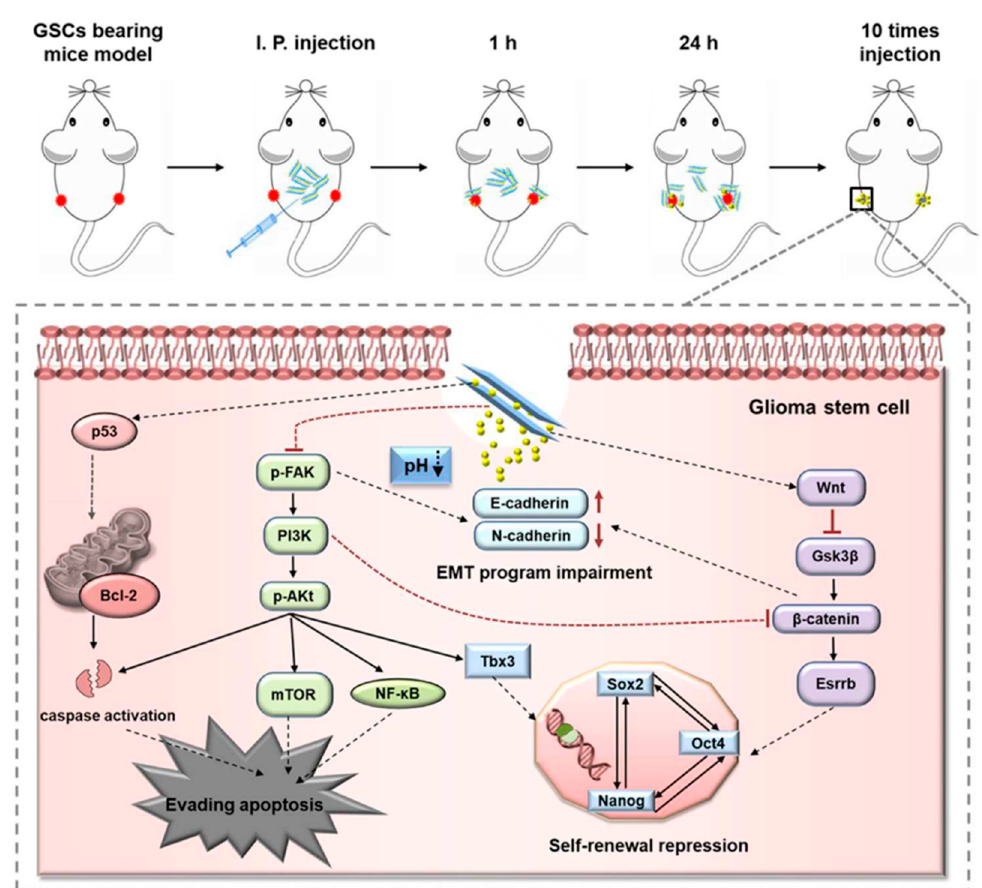
Figure 19. Molecular mechanisms involved in etoposide LDH NPs reversing chemoresistance and eradicating human glioma stem cells. Republished with permission from the Royal Society of Chemistry, from Ref. [238]; permission conveyed through Copyright Clearance Center, Inc.